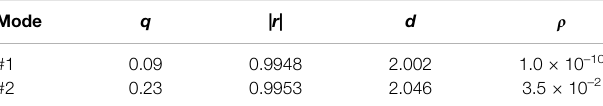
TABLE 5 | Comparison of two stretched exponential modes for the Metropolis of Tokyo ( n (cid:1) 53). Mode